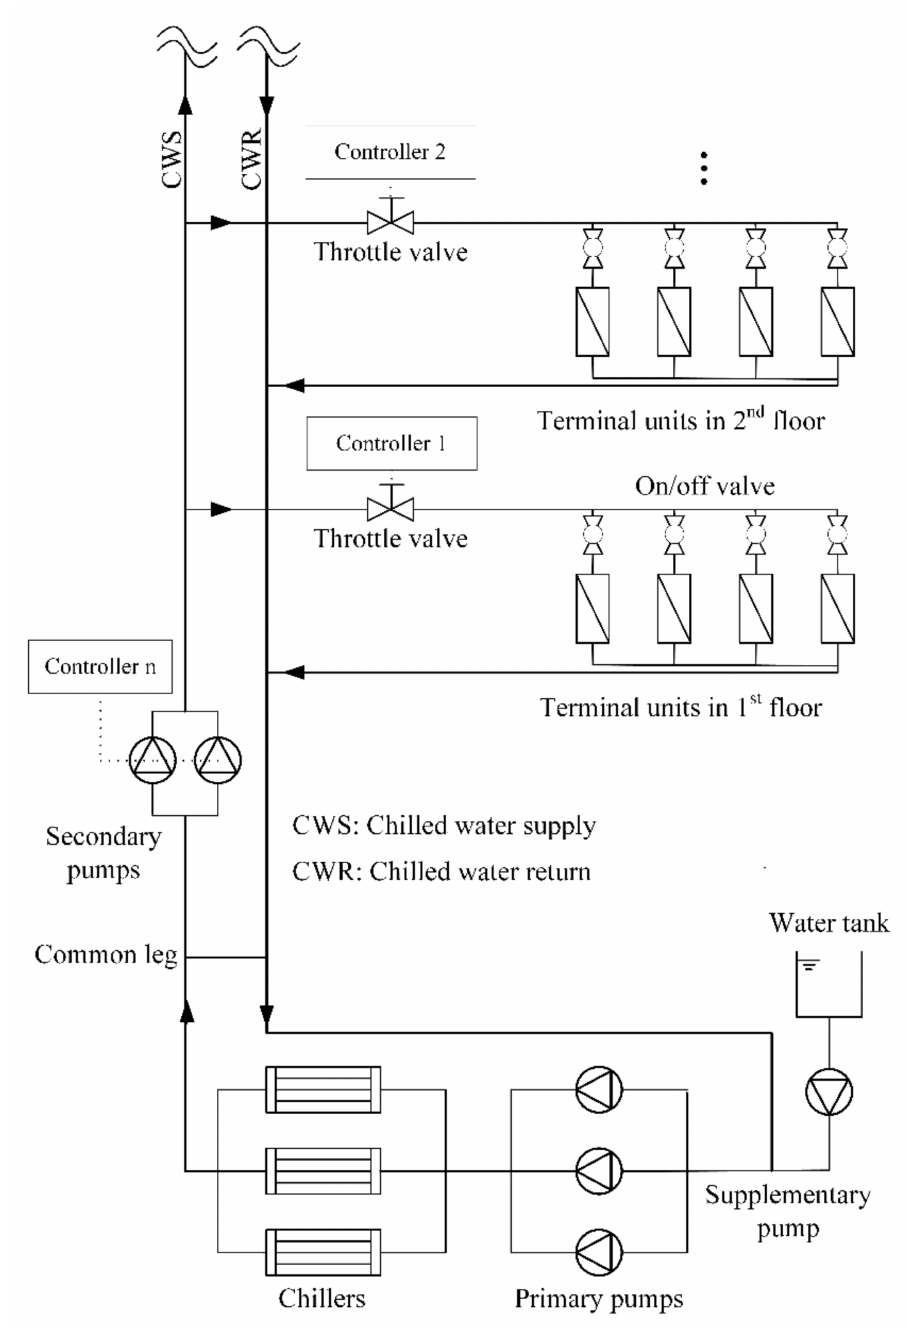
Figure 1. A typical configuration of a chilled water distribution